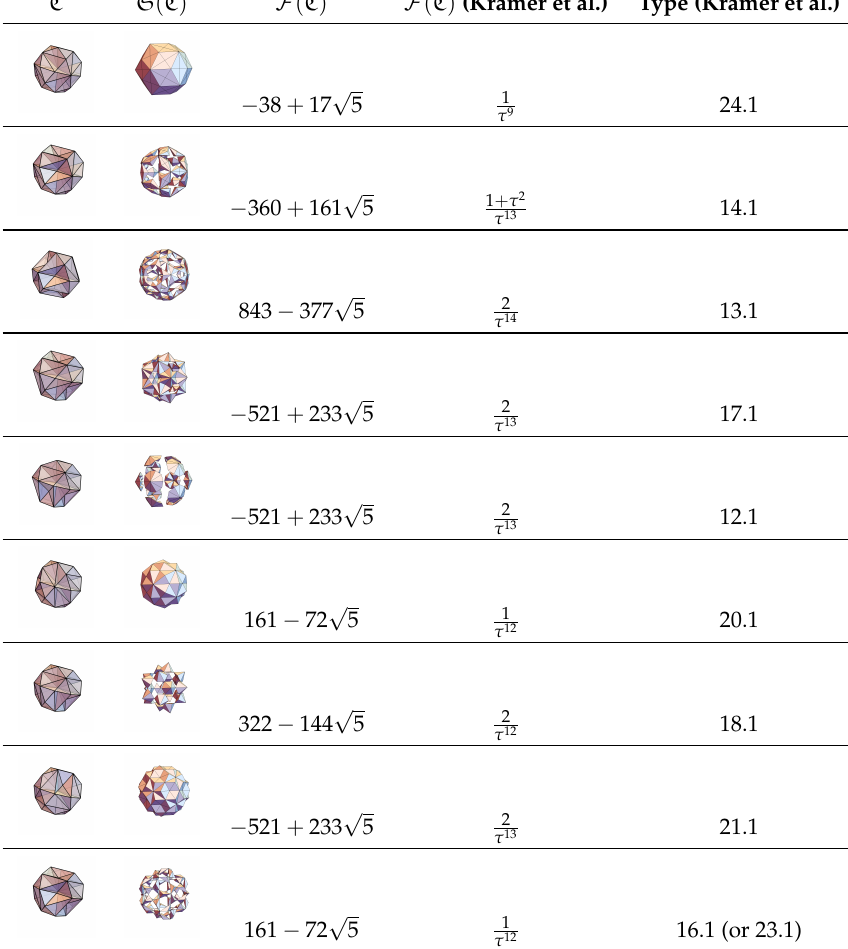
Table 2. Comparison of data computed for the T ( D 6 ) by authors and by Kramer et at. [18]. Here, √ τ = ( 1 + 5 ) /2 is the Golden Ratio and the ambiguity between types 16.1 and 23.1 is